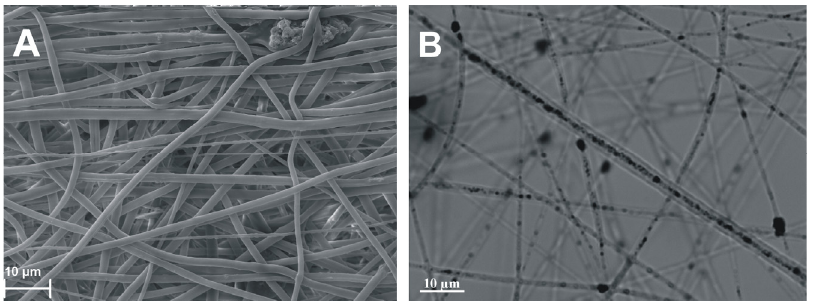
Figure 3. Fine structure of ACN-enriched scaffold 7PCL(5AC/PVP). ( A ) SEM image of scaffold. ( B ) Optical microscopy of scaffold on an Axiovert 200 microscope (Carl Zeiss, Germany), magnification ×2000 with immersion.